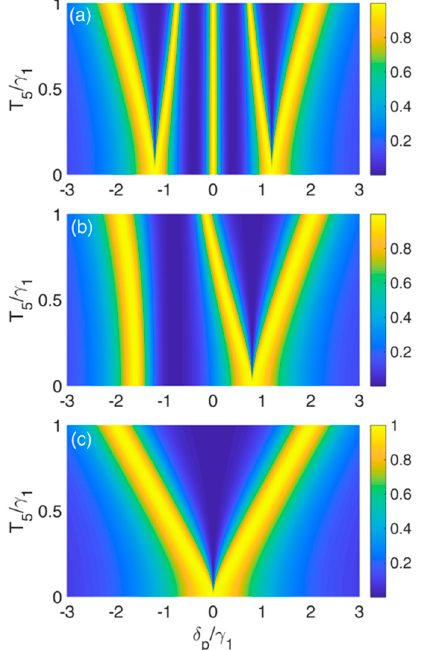
δ and tunneling intensity Figure 2. Linear absorption Im (cid:104) χ ( 1 ) (cid:105) as functions of probe detuning δ p and tunneling intensity T 5 for p